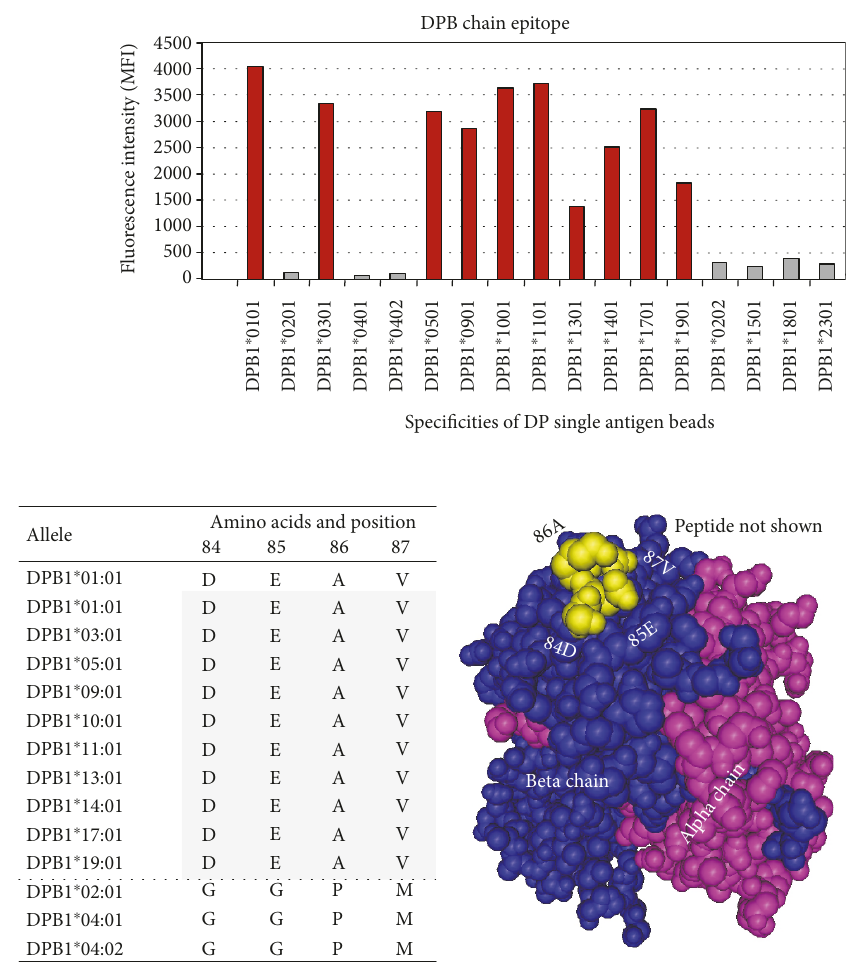
Figure 14: HLA class II DP epitope 4001 shared by DPB chains DPB1 ∗ 0101 , DPB1 ∗ 0301 , DPB1 ∗ 0501 , DPB1 ∗ 0901 , DPB1 ∗ 1001 , DPB1 ∗ 1101 , DPB1 ∗ 1301 , DPB1 ∗ 1401 , DPB1 ∗ 1701 , and DPB1 ∗ 1901 (red bars) and de fi ned by 84D+85E +86A +87V. Negative antigens that did not share epitope 4001 are shown in (gray